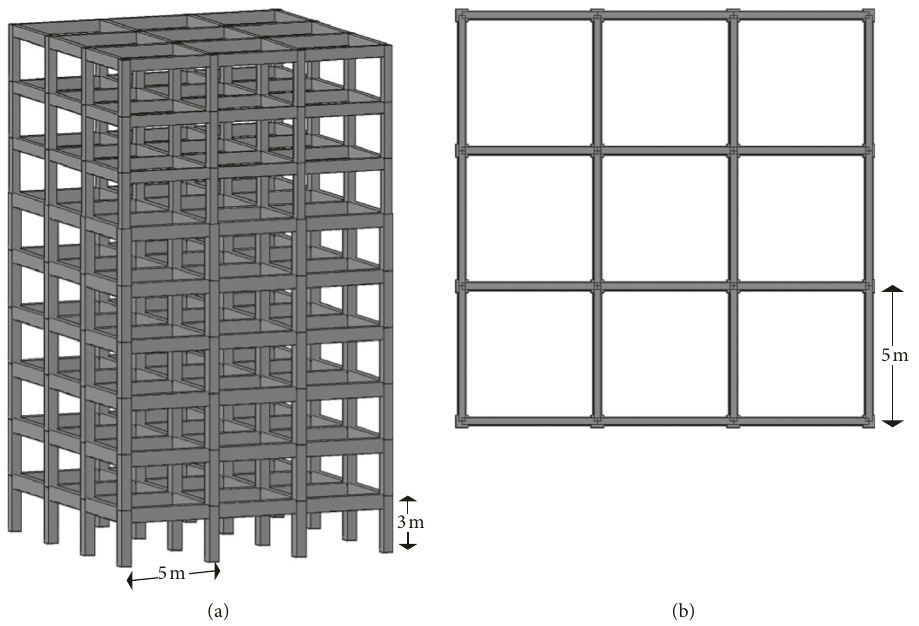
Figure 6: Model RC-9, with 7 objective sections. (a) Three-dimensional view. (b) Plan